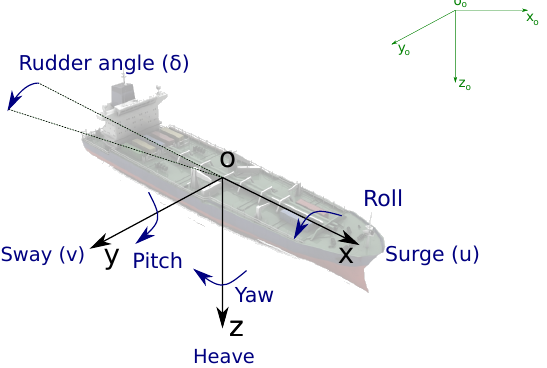
Figure 1. 6 DOF motion representation with North-East-Down coordinate system (green) and body fixed reference frame